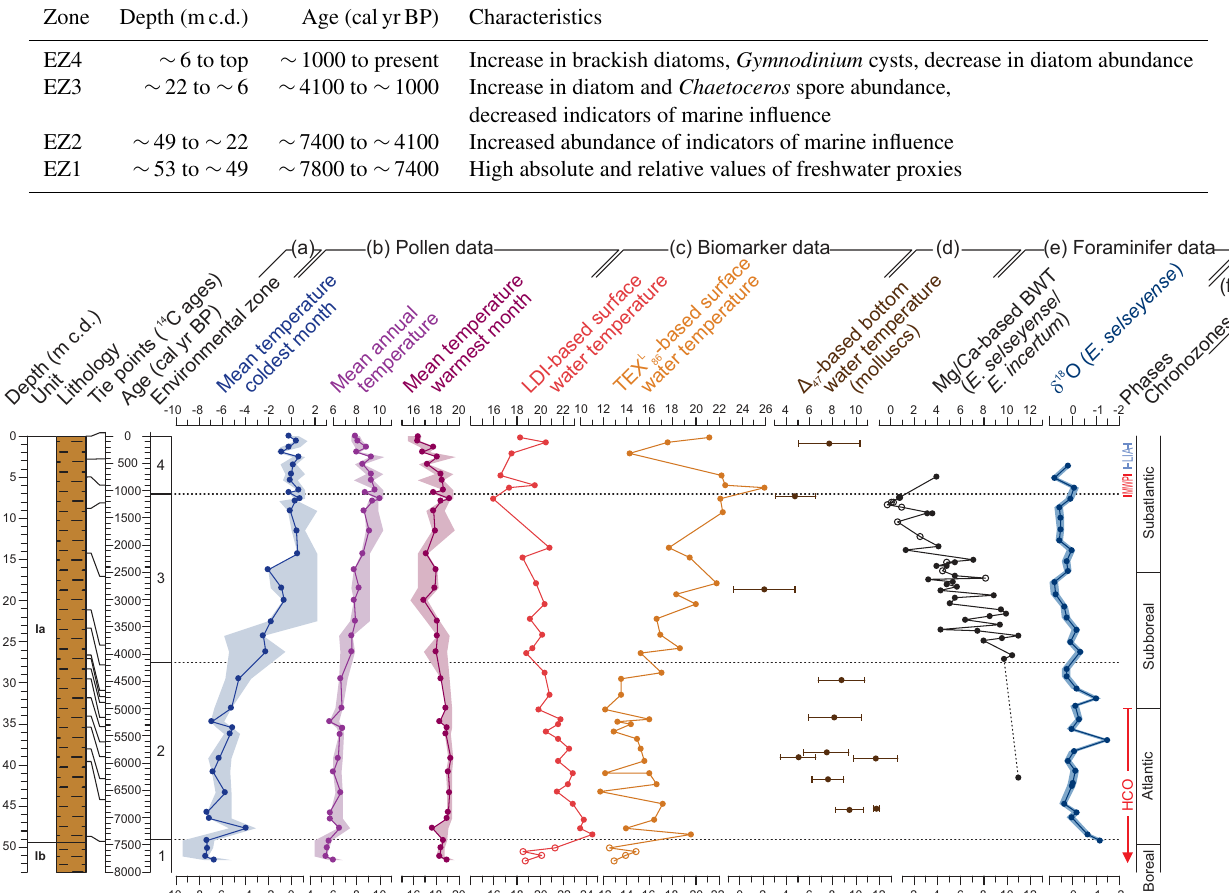
, both reflecting a summer signal. 86